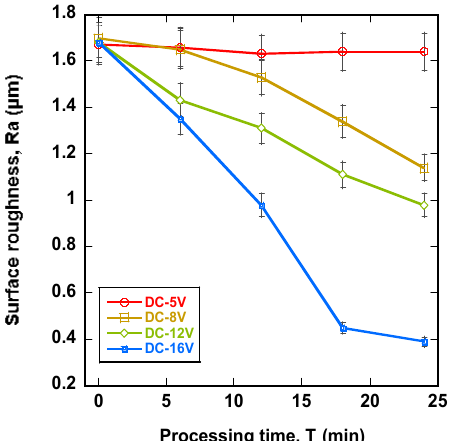
Figure 5. Comparing surface roughness by changeable flux density with a rotational speed of 800 RPM.